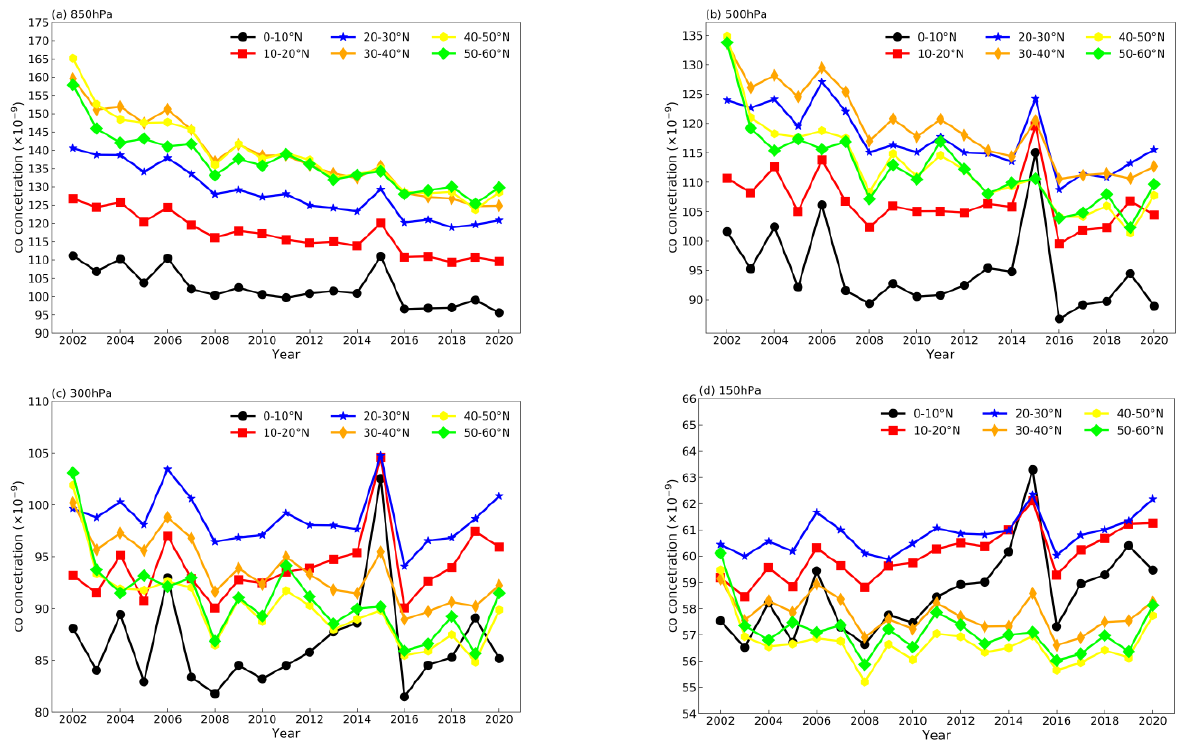
Figure 9. Interannual variation curves of different atmospheric pressure layers and latitudes in East Asia from 2002 to 2020. ( a ) 850 hPa; ( b ) 500 hPa; ( c ) 300 hPa; ( d ) 150 hPa.